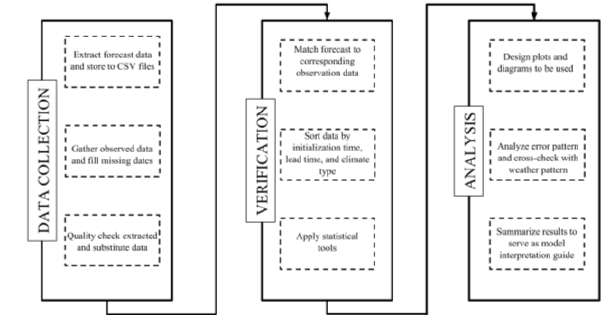
Figure 1. Locations of the synoptic stations used as validation points; stations are classified based on climate type of location. Figure 3. Flowchart showing the series of steps in